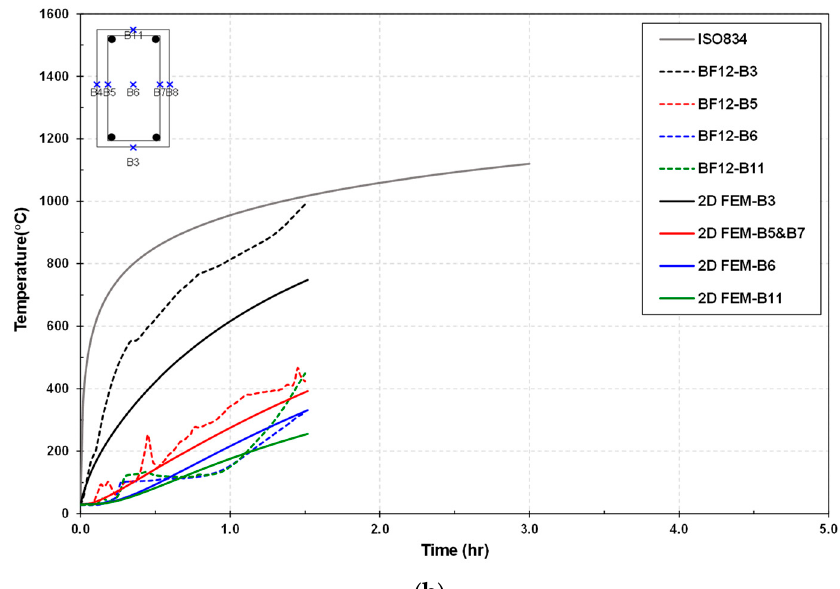
Figure 15. Comparison between prediction and test of the BF12 beam. ( a ) Reinforcements; ( b ) concrete.